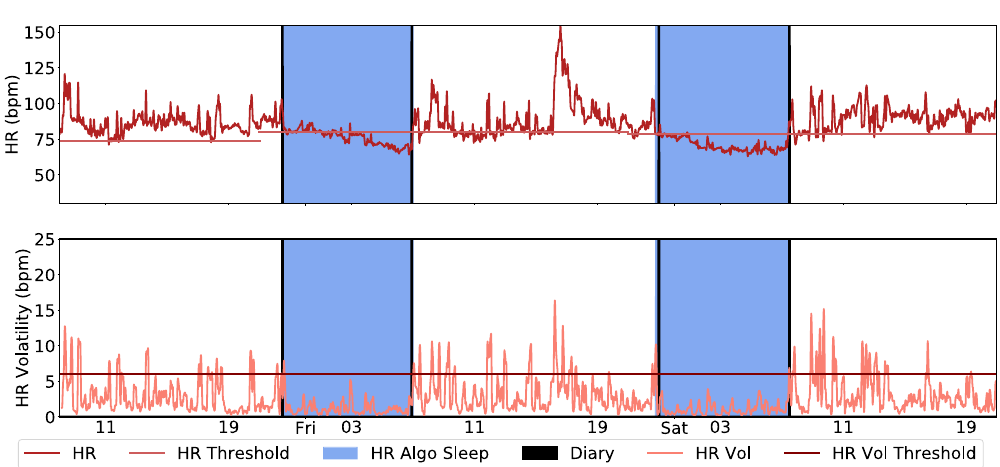
Figure 3. Heart rate sleep algorithm in action for a participant chosen at random. The first step involves setting initial sleep blocks through ECDF quantile thresholds (in this experiment, Q = .35 ). Blocks longer than L = 40 are kept and merged if the gap between blocks is smaller than G = 60 minutes. We extract the limits of the resulting blocks as candidate state changes. The bottom panel highlights the use of rolling heart rate volatility to refine these candidate times by finding nearby periods where this volatility is high. The resulting candidate times designate each day’s main sleep